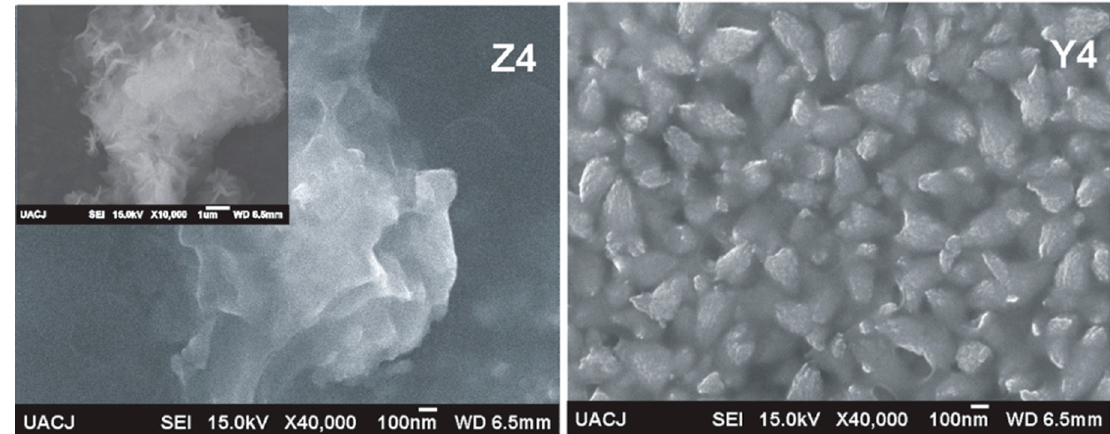
Figure 8. SEM images and morphology for the ZnO nanoparticles used for the composite polymer, the insets show less magnification with some bright spots related to ZnO nanoparticles.